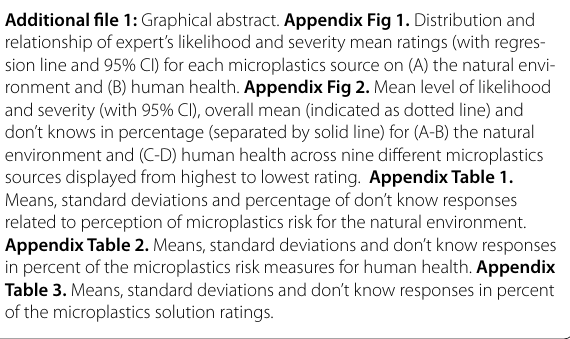
Table 3. Means, standard deviations and don’t know responses in percent of the microplastics solution